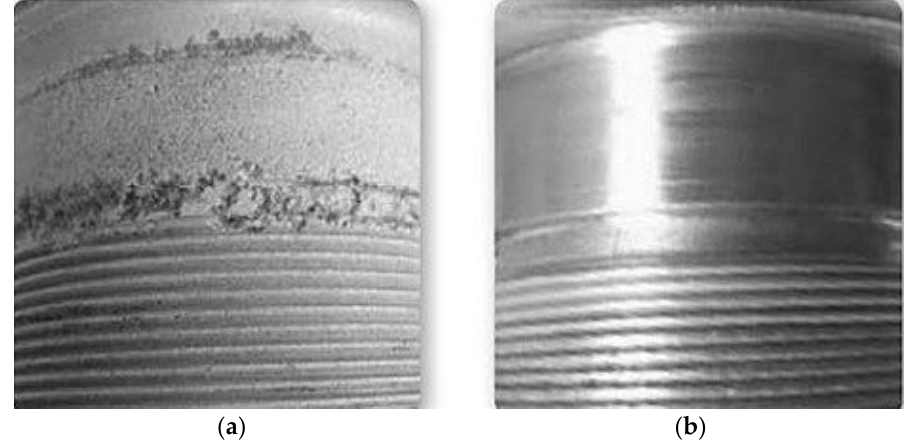
Figure 20. Photographs of ( a ) defected Boeing nose wheel steering actuator and ( b ) cold spray nickel repaired 737 nose wheel steering actuator [62].